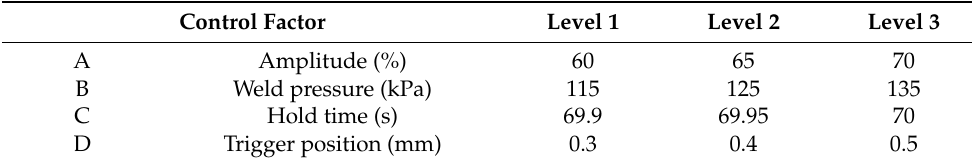
Table 1. Process control factors and their